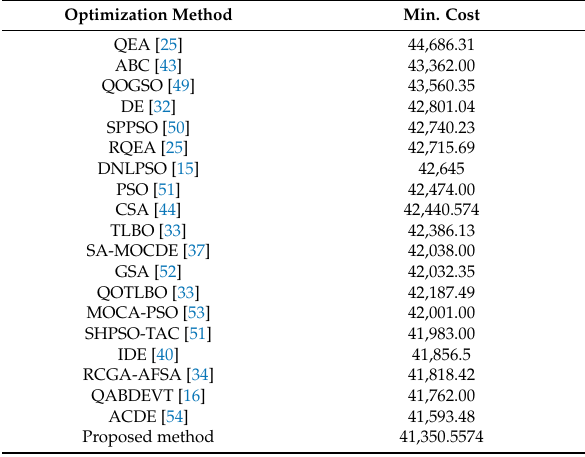
Table 8. Comparisons of simulation results for test system 2 case